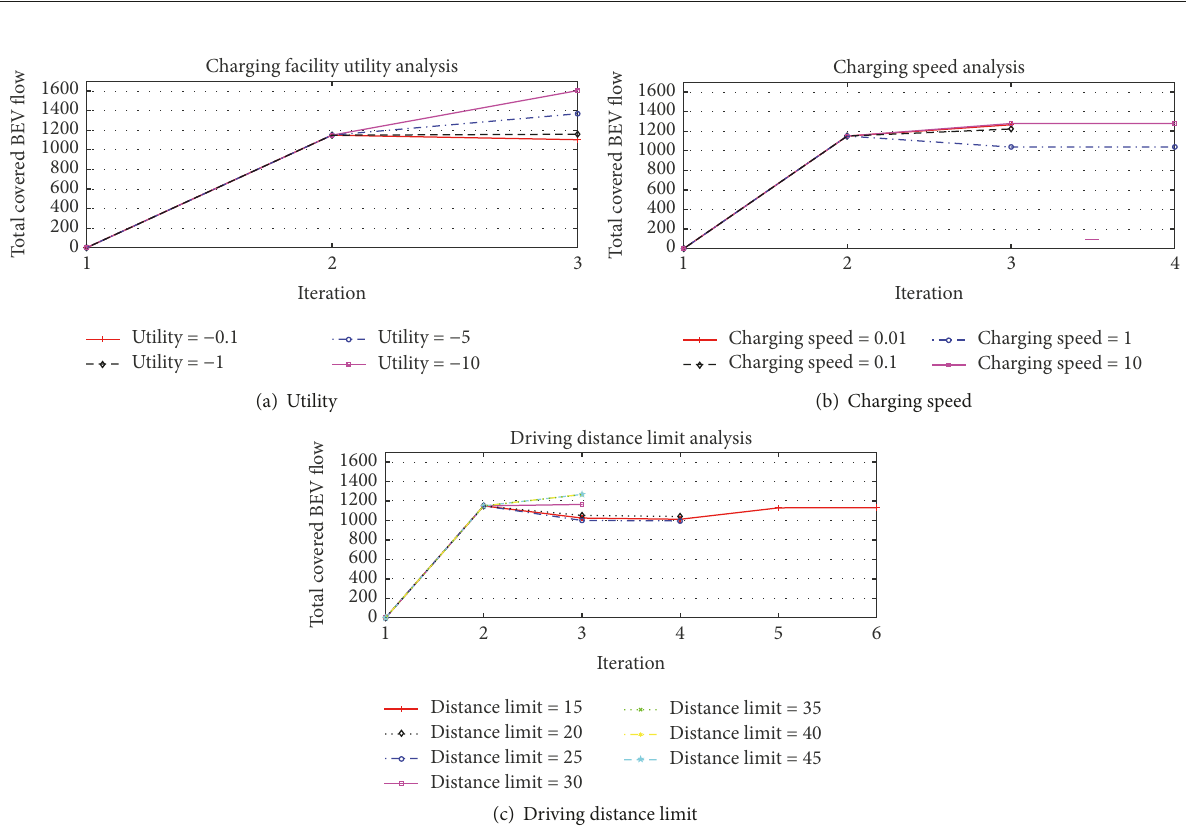
Figure 4: Sensitivity analysis for various input parameters (a) charging facility utility; (b) charging speed; and (c) driving distance limit on the total covered BEV